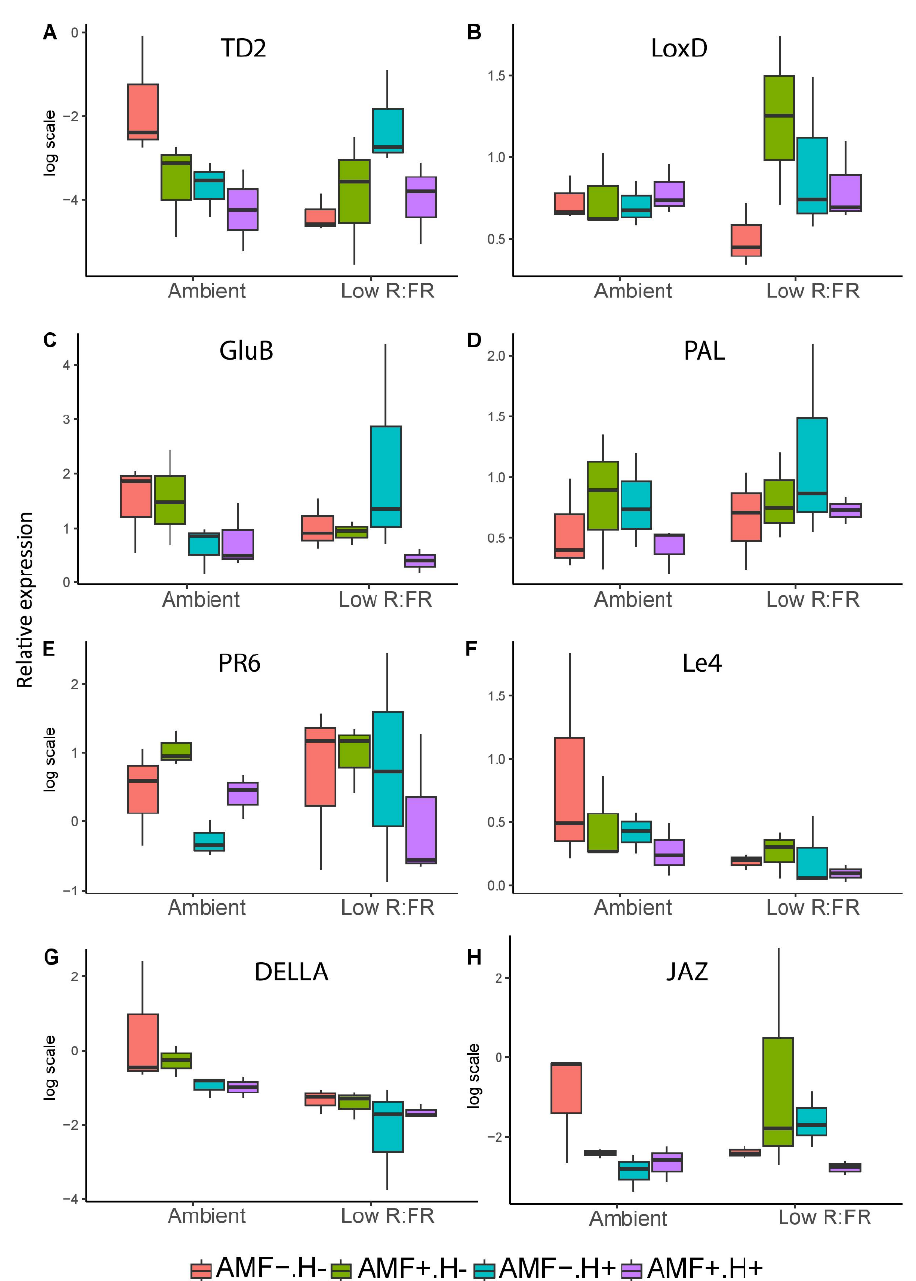
Figure 5. Relative expression of eight genes ( A – H ) related to light and defense signaling in tomato plants grown under two light (Ambient, Low R:FR) and two inoculation treatments (AMF − : no mycorrhiza, AMF+: mycorrhiza) in the absence (H − ) or presence (H+) of herbivory by unparasitized Spodoptera exigua caterpillars. Values are delta-delta-Ct values normalized to the expression of the housekeeping gene CAC. The median is represented by the thick horizontal line; the box is defined by the 25th and 75th percentiles (lower and upper quartile).